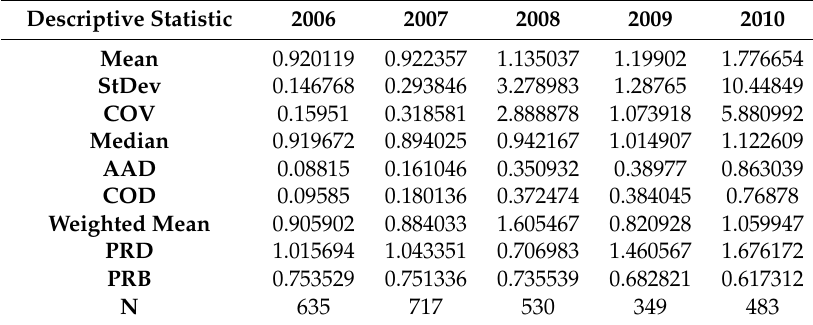
Table 2. Overall ratio descriptive statistics for all qualified sales in New Haven.